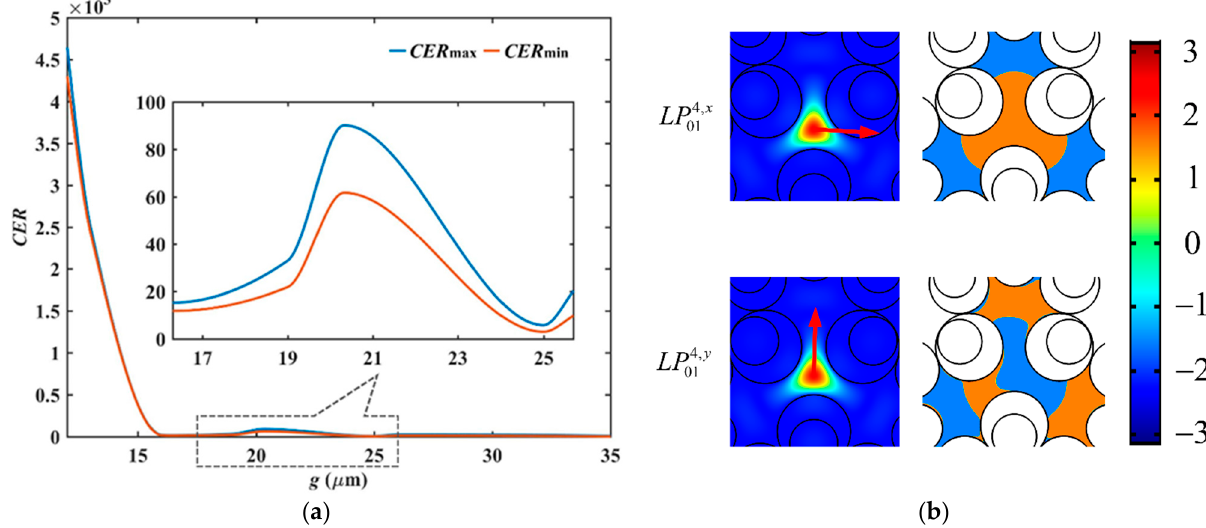
Figure 12. ( a ) Change in the central mode extinction ratio with g ; ( b ) Electric field distribution (left) and phase distribution (right) of the fundamental supermode (LP 4,x coupled fiber. The color legend is for the phase distributions, the direction of red arrows represents the direction of the electric field.